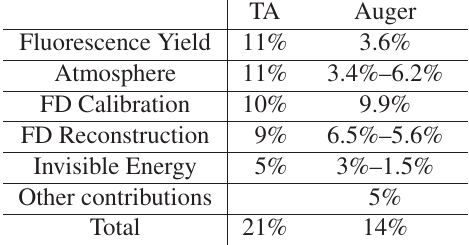
Table 1. Systematic uncertainties in the energy scale for TA [10] and Auger [11]. The mild energy dependence of the uncertainties is reported for